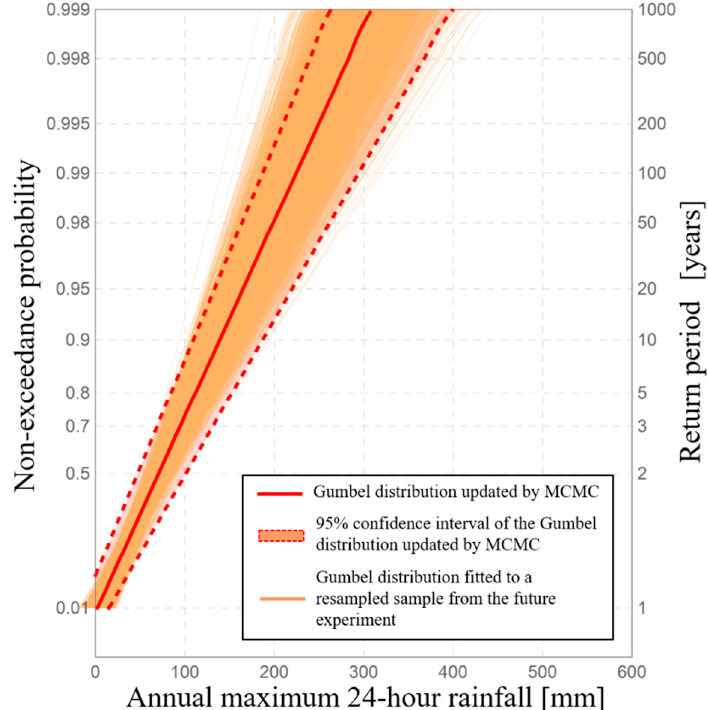
Figure 14. 95% confidence interval based on probability limit method test for future climate and Gumbel distributions fitted to each of the 5000 resampled samples of future experiment.